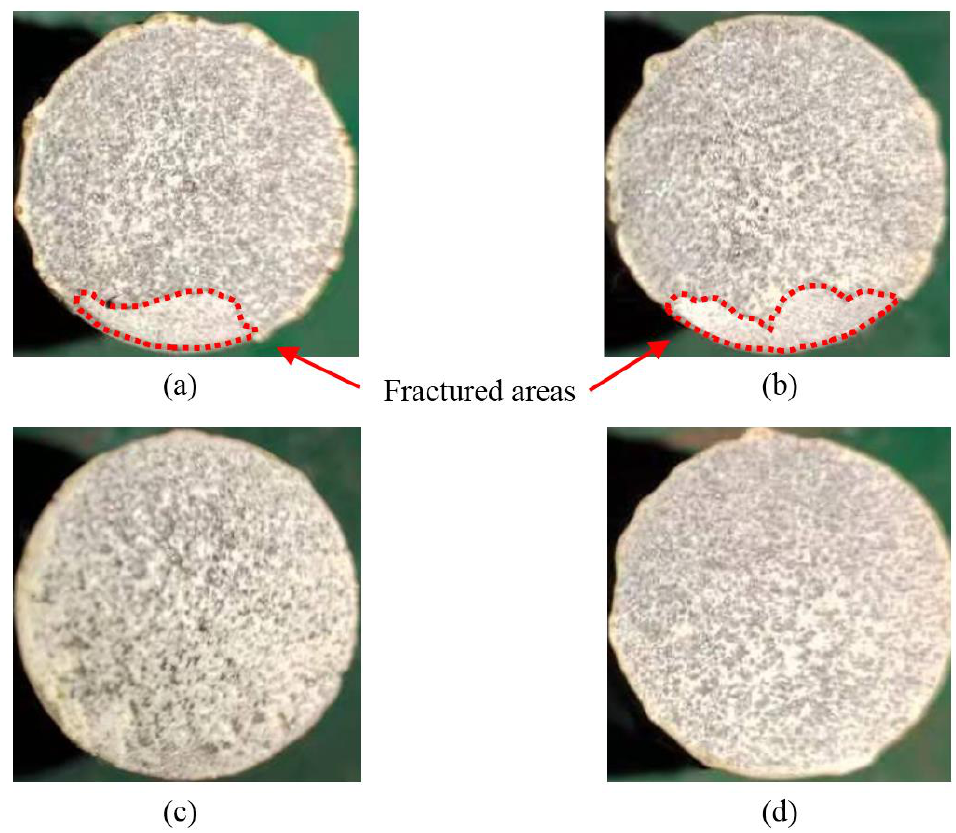
Figure 11. Adhesive surfaces after tensile adhesion test (TAT): ( a,b ) NiAl coatings on 7075 substrates, ( c,d ) NiAl coatings on 304 substrates. Table 5. Reported bonding strengths, spraying and pre-treating methods in other studies.